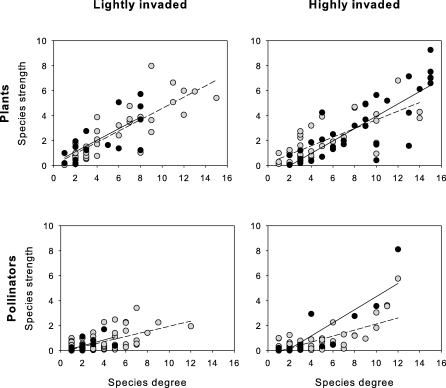
Relation of a Species' Strength to Its DegreeA species' strength is the sum of the dependences of the species with which it interacts, whereas its degree is the number of species with which it interacts. The figure depicts separate relations for native (gray circles) and alien (black circles) plant and pollinators species present in lightly and highly invaded webs. The dashed and continuous lines represent the best-fit linear regressions for native and alien species, respectively (p < 0.001 in all cases). Sample sizes for natives and aliens are, respectively, 36 and 15 for plants in lightly invaded webs, 37 and 34 for plants in highly invaded webs, 113 and 15 for pollinators in lightly invaded webs, and 162 and 19 for pollinators in highly invaded webs.